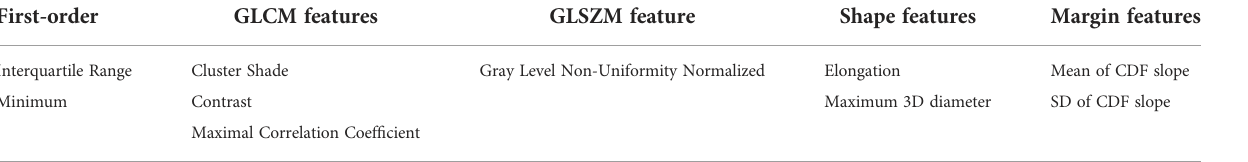
TABLE 2 Selected radiomics features for the radiomics-based prediction model.